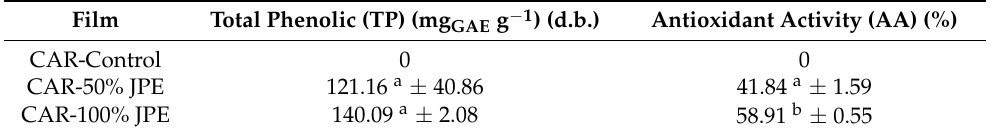
Table 3. Bioactive properties of films.